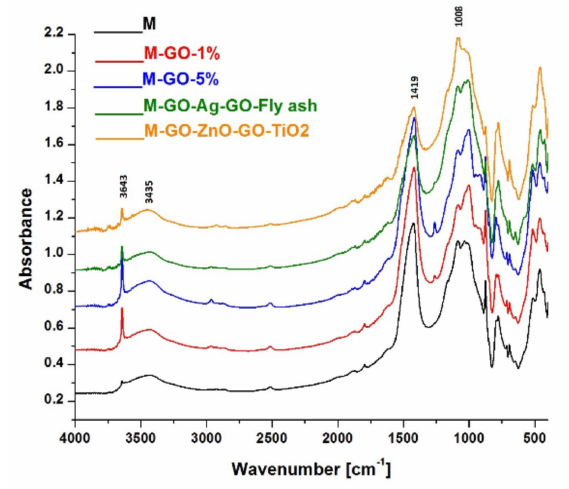
Figure 1. FT-IR spectra of the investigated mortars. Table 2. The main maxima identified in the FT-IR spectra of the investigated mortars. Mortar